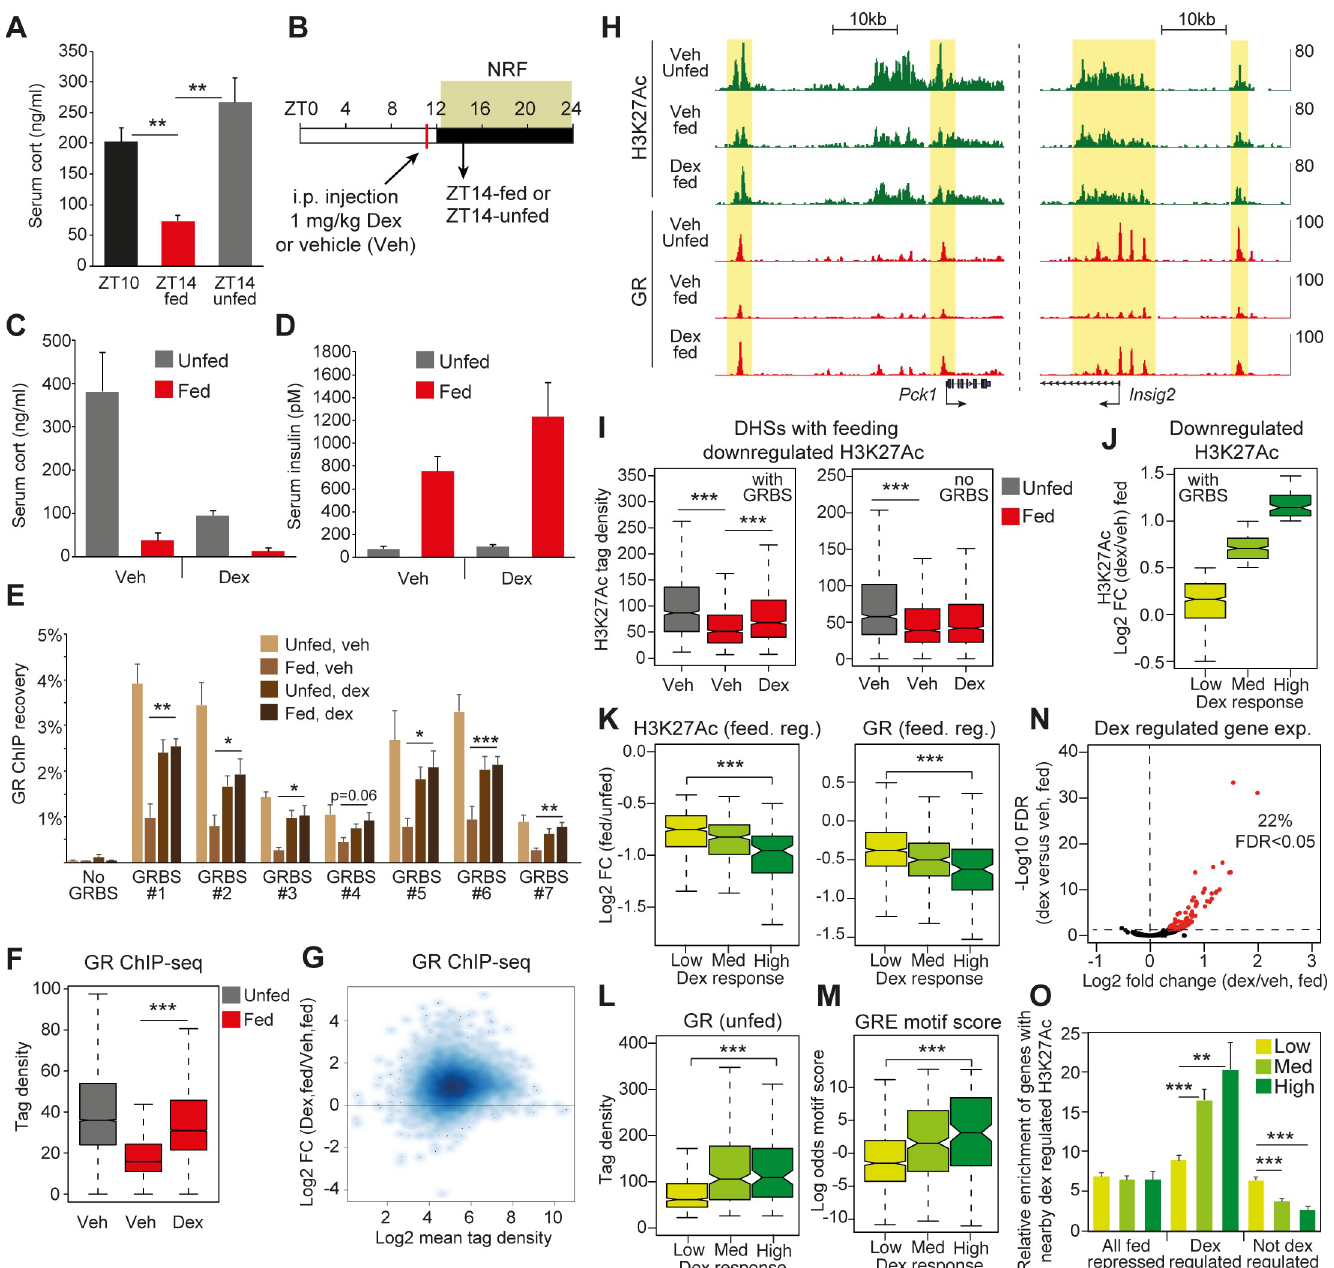
Fig 5. Regulation of postprandial enhancer activity by GR. (A) Corticosterone levels in serum from mice euthanized at ZT10, ZT14-fed, and ZT14-unfed. (B) Preprandial dex (or vehicle) injection protocol for animals trained to NRF. Animals were euthanized at ZT14-fed and ZT14-unfed. (C) Corticosterone and (D) insulin levels in serum of animals injected with dex or vehicle. (E) GR occupancy of seven different GRBS and one control site (no GRBS). (F) Genome-wide occupancy of GR in livers isolated from mice euthanized at ZT14-unfed (vehicle injected) and ZT14-fed (vehicle or dex injected). (G) Effect of dex injection on genome-wide GR occupancy in fed animals at ZT14. (H) Dex-regulated GR occupancy and H3K27Ac near Pck1 and Insig2 . Yellow marks H3K27Ac regions occupied by GR. (I) Effect of dex injection on H3K27Ac at feeding-repressed enhancers with and without a GRBS. (J) Effect of dex injection on H3K27Ac at feeding-repressed enhancers with a GRBS. Enhancers are grouped into three bins based on differential H3K27Ac levels in response to dex. (K) Feed. reg. H3K27 acetylation (left) and GR occupancy (right) of feeding-repressed enhancers acetylated to a different degree by dex injection. (L) Level of GR occupancy of enhancers with differentially H3K27Ac after dex injection. (M) GRE motif score within enhancers differentially H3K27Ac by dex. (N) Differential expression of feeding-repressed genes affected by dex injection compared to animals injected with vehicle (quantified by RNA-seq). Red marks genes induced by dex at FDR < 0.05 ( n = 4 in each treatment group). (O) Relative enrichment of feeding-repressed genes (dex-regulated or not) harboring dex-regulated enhancers within 50 kb of the TSS. Enrichment is relative to six sets of 400 randomly selected genes. Data in panels A, C, D, E, and N are presented as mean ± SEM ( n = 4–6). Statistical significance is calculated using Student t test. Statistical analysis in panels F, I–M is performed by a Mann–Whitney–Wilcoxon test. � p < 0.05, �� p < 0.01, ��� p < 0.001. Numerical values for panels A, C–G, and I–O are